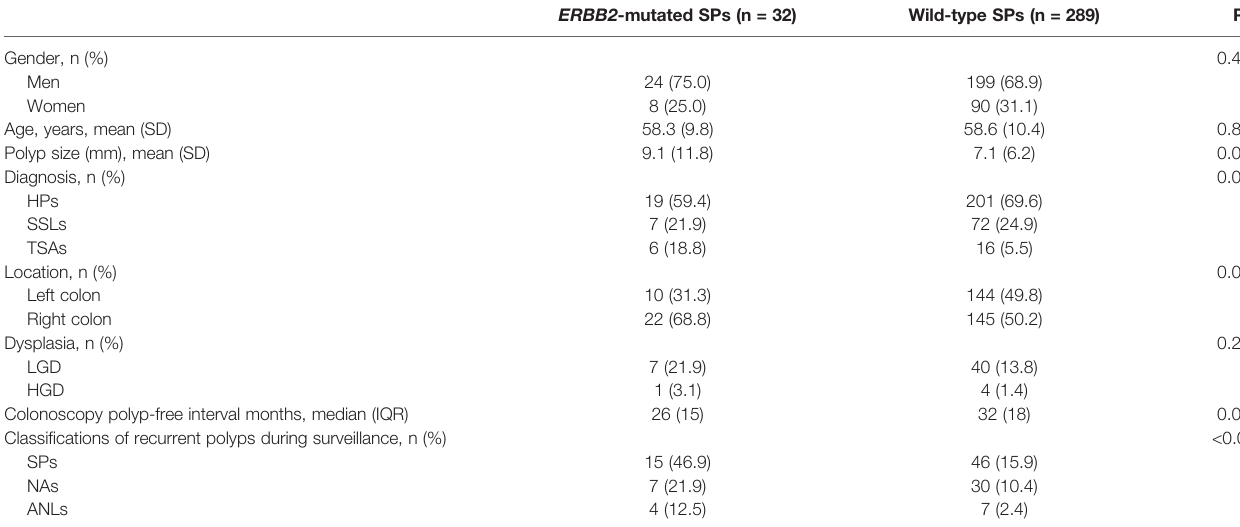
TABLE 2 | Baseline characteristics of the validation cohort of SPs according to fi ndings on index colonoscopy (total n = 321). ERBB2 -mutated SPs (n = 32)